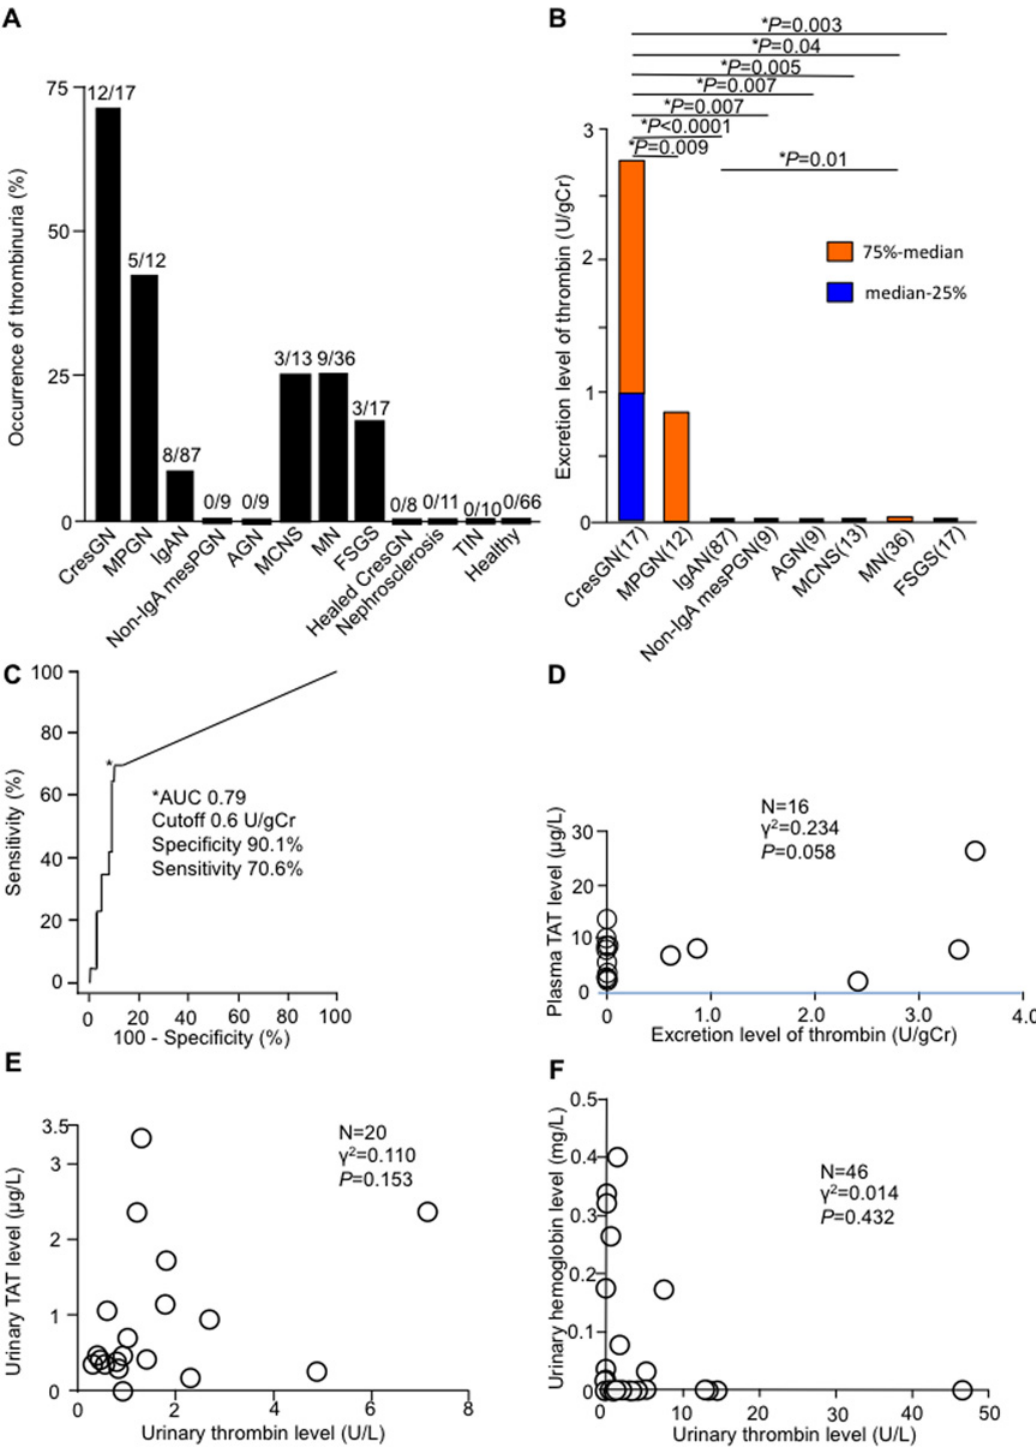
Fig 1. Thrombinuria in glomerulonephritis and its diagnostic accuracy for crescentic glomerulonephritis (CresGN) and its relation to plasma thrombin-antithrombin complex (TAT), urinary TAT, and hemoglobinuria. ( A ) Occurrence of urinary thrombin detected ( > 0.2 U/L) in each group; fractions over the columns indicate the number of samples with thrombin activity per the total number of samples. ( B ) Thrombin excretion level for each type of glomerulonephritis, as shown by box plots that indicate the median-25th and 75th-median percentiles. Bars with asterisks ( * ) show only significant differences between two groups. MPGN, membranoproliferative glomerulonephritis; IgAN, IgA nephropathy; non-IgA mesPGN, non-IgA mesangial